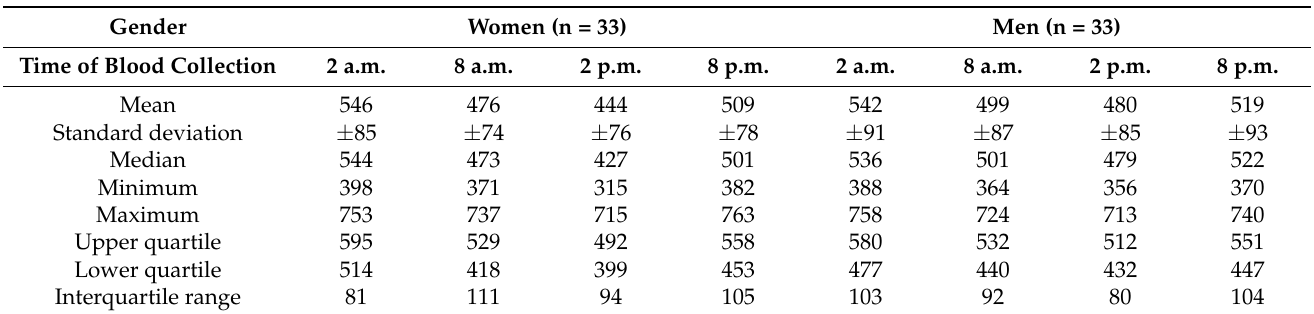
Figure 1. The average serum concentration of melatonin in men and women at different sampling time points. Data presented as mean ± 95% confidence interval. MANOVA-type analysis ( p = 0.82172). Table 3. Parameters describing the activity of superoxide dismutase (SOD-1) in women and men including the time of blood collection [U/g